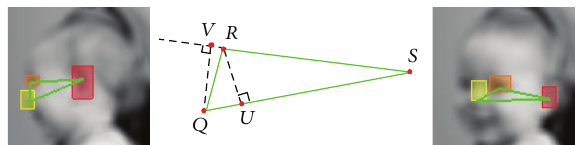
Figure 7: The triangle created by the left ear, left eye, and nose. The leftmost and rightmost images depict the triangle when the infant is lookingrightandmoretowardsthecamera,respectively.Themiddle image shows the points used for calculating ̂ yaw.